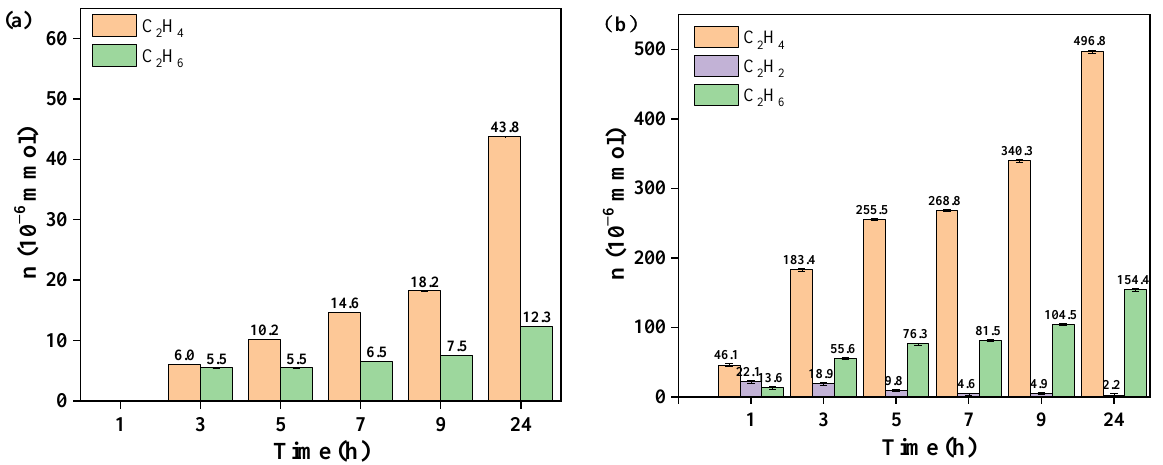
Figure 6. Gas phase production during TCE degradation with: ( a ) neat nZVI; and ( b ) S-nZVI with a Fe/S ratio of 10 (pH: 7, T: 30 °C; nZVI and S-nZVI: 0.026 g).